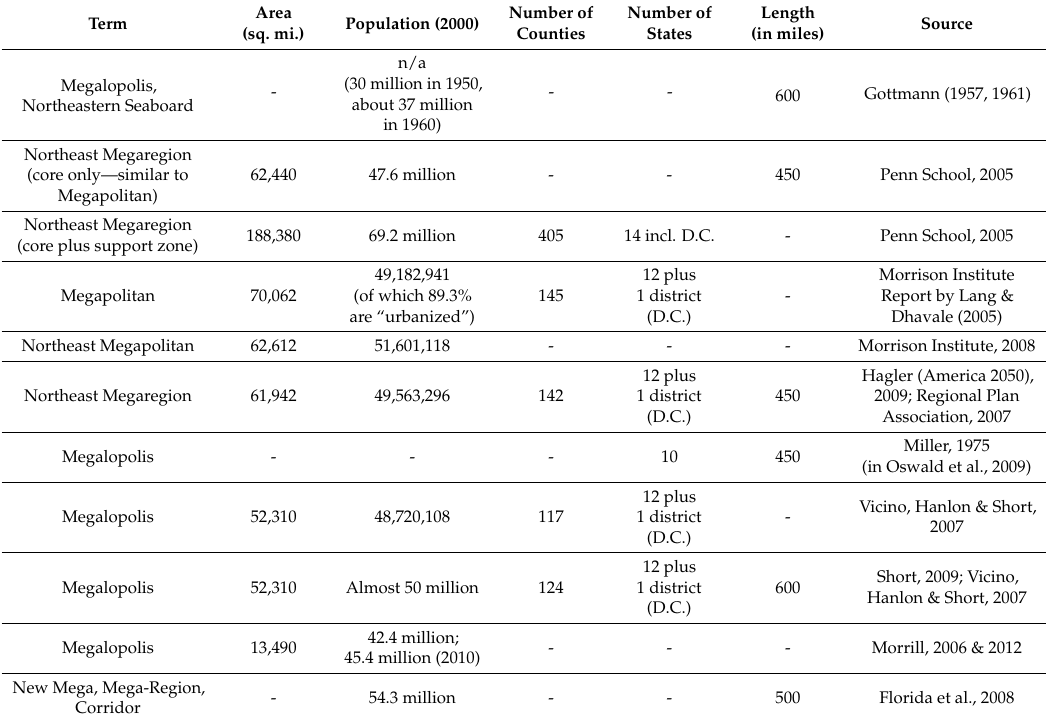
Table 1. Ambiguous descriptions and delimitations: Different spatial and socio-economic indicators of Boswash presented in various studies.